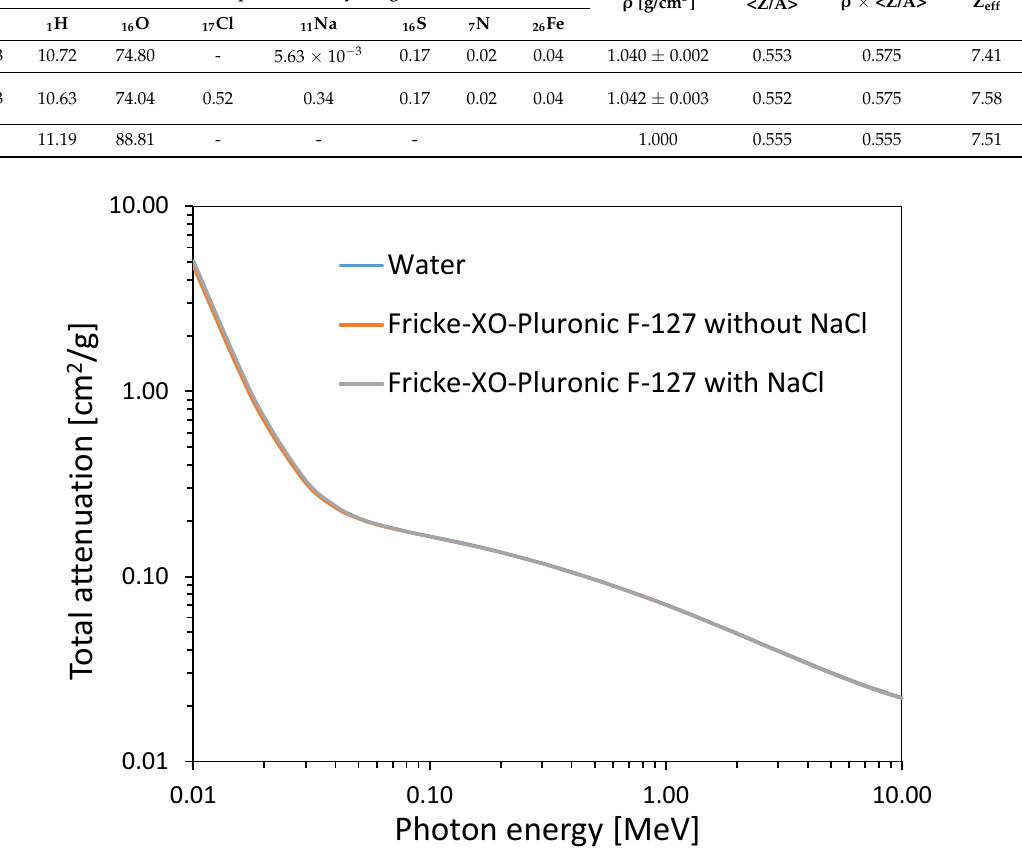
Table 3. Elemental composition and tissue equivalence of Fricke-XO-Pluronic F-127 without and with 0.2 M NaCl in reference to water.